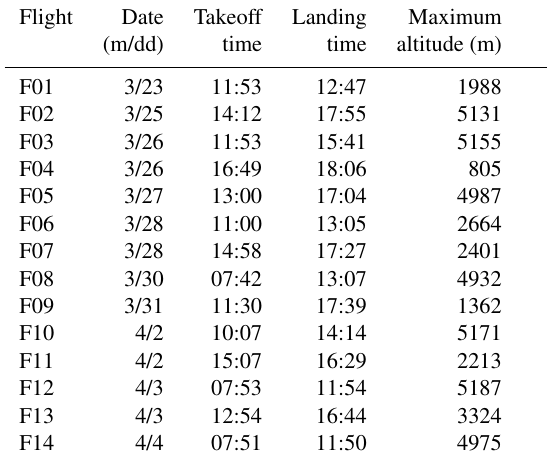
Table 1. Summary of research flights made during the PAMAR- CMiP experiment. The time is